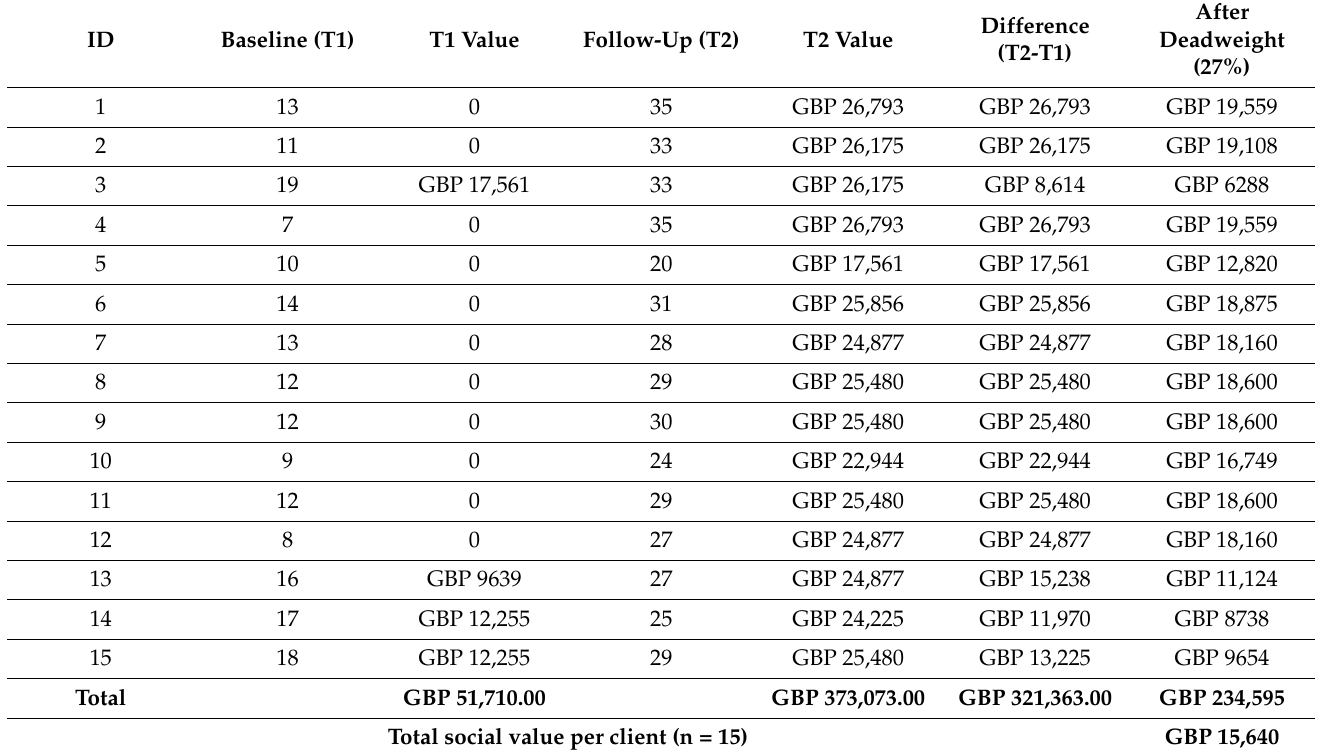
Table 7. Social value for face-to-face clients using the mental health social value calculator.